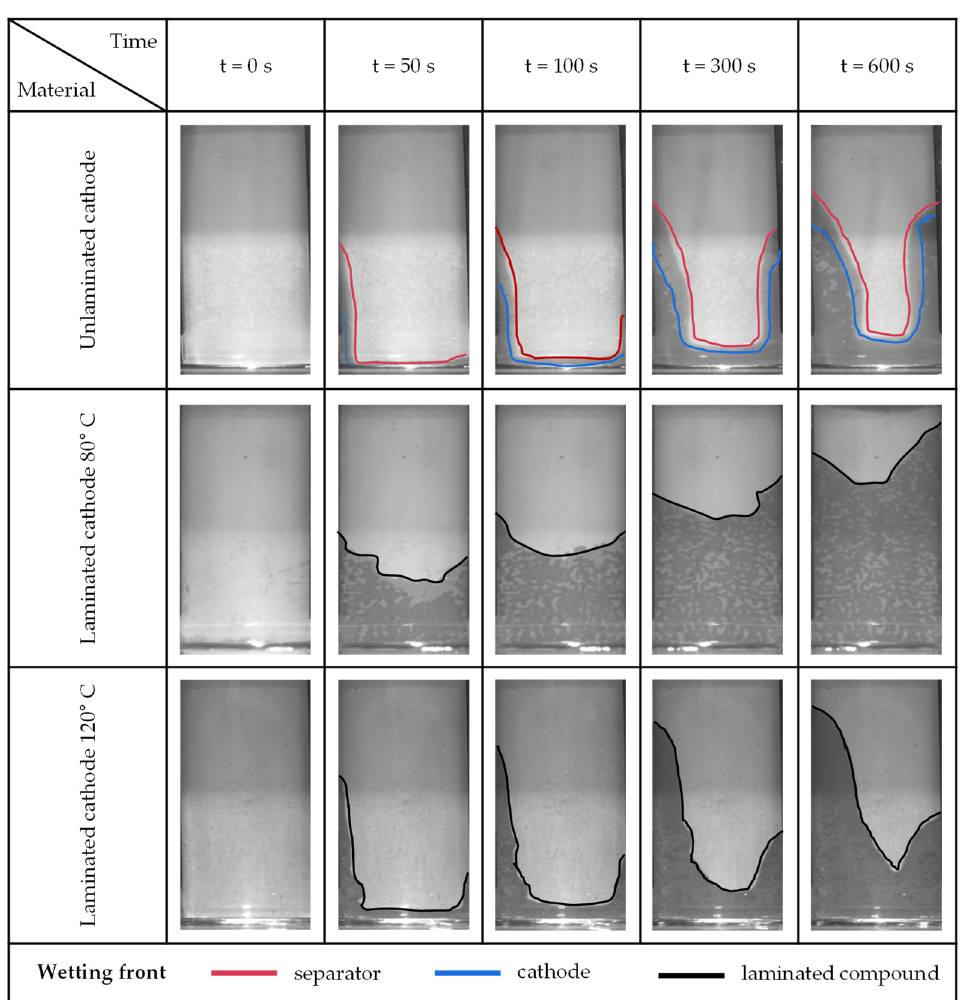
Figure 5. Images of the optical measurement of the cathode separator measurement series at four time points. The shape and height of the wetted visible surface are shown. Start of the measurement at t = 0 s.